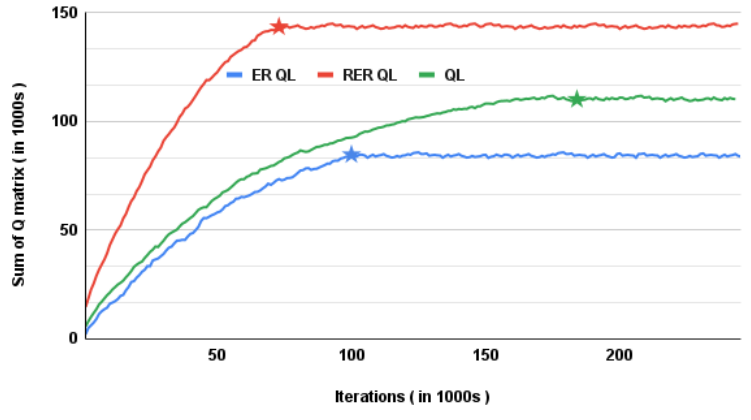
Figure 3. Convergence of Q-learning, ER Q-learning, and RER Q-learning based